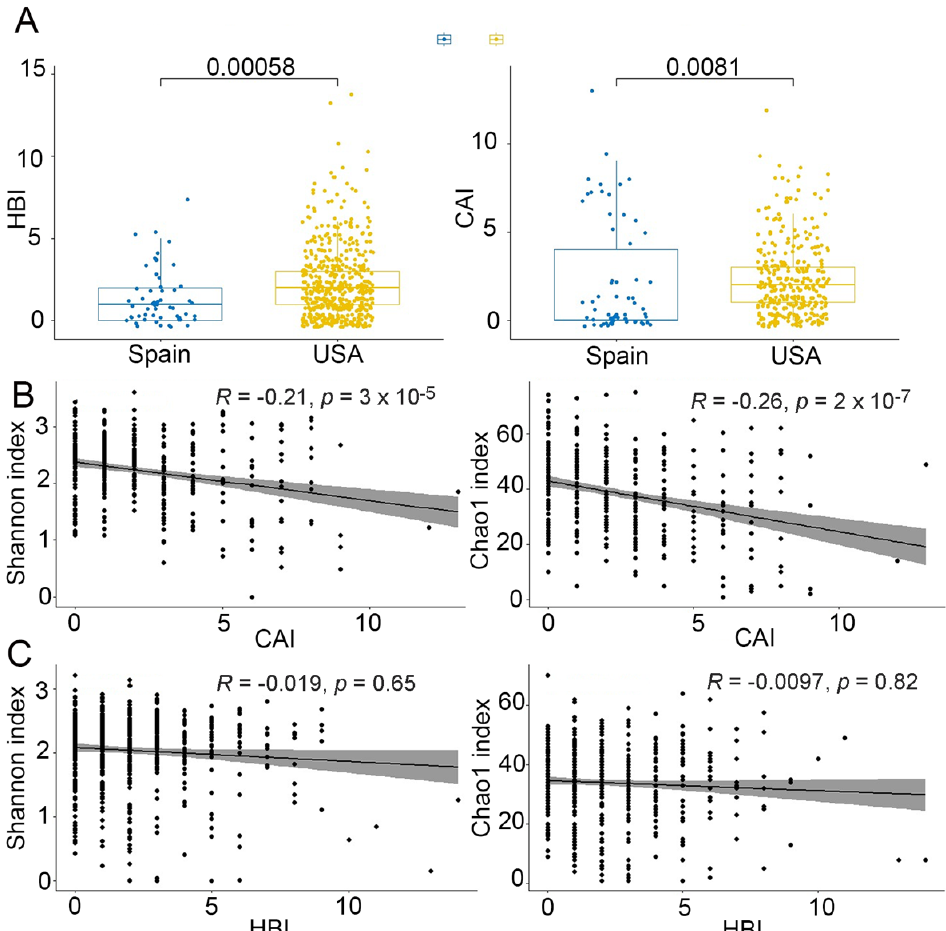
Figure 3. Disease activity score in CD (HBI, Harvey-Bradshaw index) and UC (CAI, colitis activity score). ( A ) HBI and CAI were both higher in the USA than in the Spanish cohort (Mann Whitney’s U test). ( B ) Correlation between alpha-diversity (Shannon and Chao1 indices) and CAI (Spearman correlation test). rho = − 0.019, p = 0.65 for the Shannon index and rho = − 0.0097, p = 0.82 for the Chao1 index. ( C ) Correlation between alpha-diversity (Shannon and Chao1 indices) and HBI (Spearman correlation test). rho = − 021, p = 3 × 10 − 5 for the Shannon index and rho = − 0.26, p = 2 × 10 − 7 for the Chao1 index.